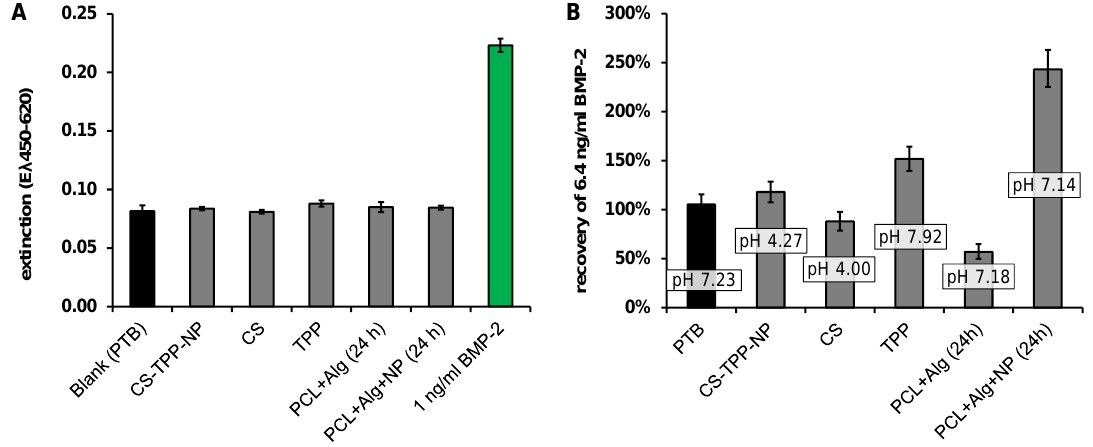
Figure 6. Effect of 0.3 mg mL-1 CS-TPP-NP/CS/TPP or an 24 h extract (release conditions) from an alginate coated (PCL-Alg) or an alginate and CS-TPP-NP coated (PCL + Alg + NP) implant prototype on: ( A ) the ELISA signal without BMP-2 (last column: signal of 1 ng/mL BMP-2 in PTB for comparison) and ( B ) the recovery of 6.4 ng/mL BMP-2 ( n = 3, error bars indicate SD).